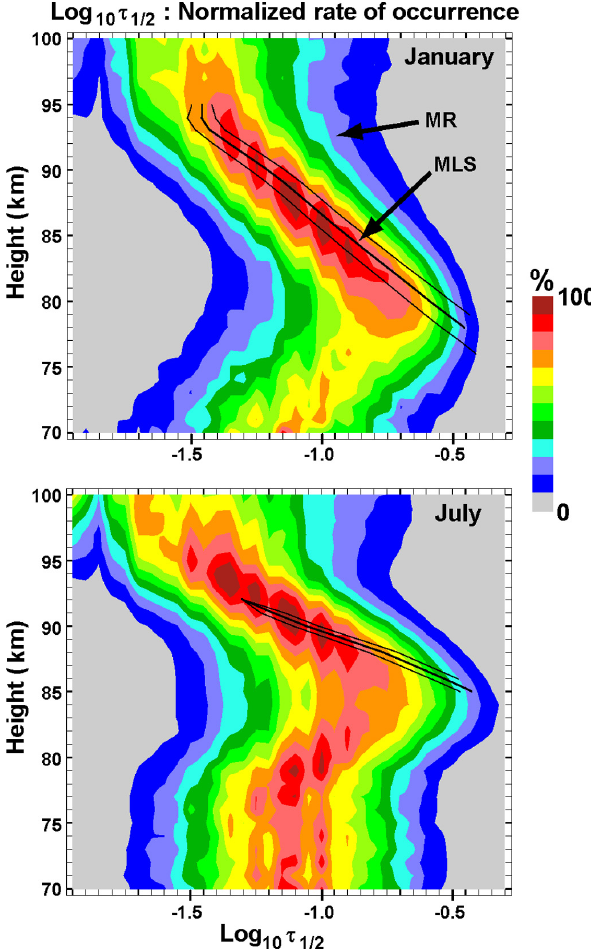
Fig. 8. log 10 τ 1 / 2 calculated from Aura MLS T and P by Eq. (6) compared with the Eureka MR percentage occurrence (relative to the total at each height over the 34 bins) in meteor trails for January and July (composite year 2006–2011 and part of